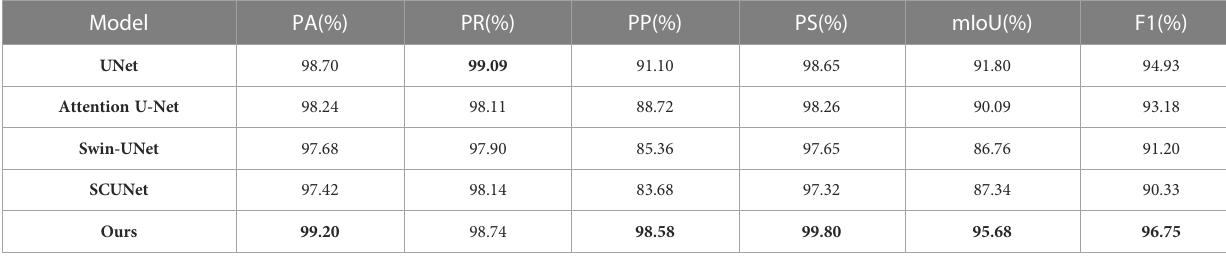
TABLE 3 The segmentation results on the SD dataset using fi ve different models.